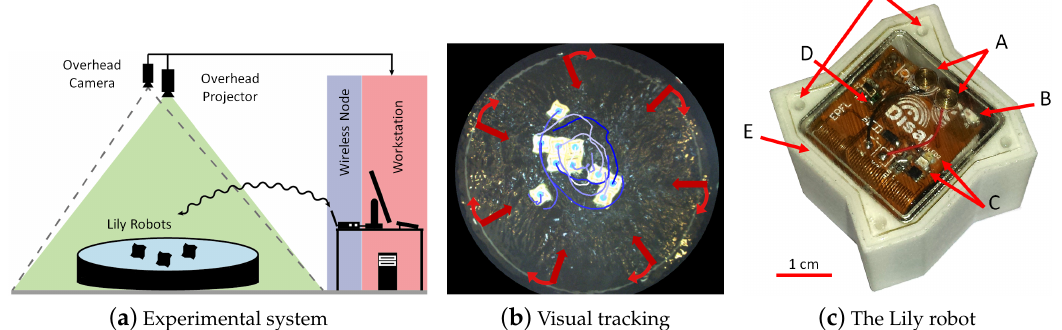
Figure 11. ( a ) The experimental setup consisting of a water-filled tank with peripheral pumps agitating the fluidic environment, an overhead camera and a projector, a wireless node for establishing the radio link between the workstation and the Lily robots; ( b ) Visual tracking of ten Lily robots during an experiment (the blue lines show a short trajectory history for each robot); ( c ) The Lily robot [61]; some key features visible in the picture are: charging contacts (A), chip antenna (B), two LEDs signaling board status (C), ambient light sensor (D), sealing gap filled with silicone paste (E) and two of the four trimming holes